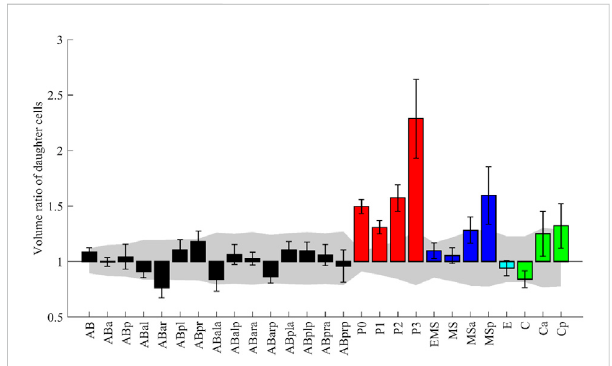
FIGURE 5 The volume ratio of daughter cells emerging from the named mother cell. The design of the graph follows (Fickentscher and Weiss, 2017). The medians of the 52 embryos are shown with error bars indicating standard deviations. Colors indicate cell lineages. The gray region indicates the volume-dependent level of uncertainty (see Methods for